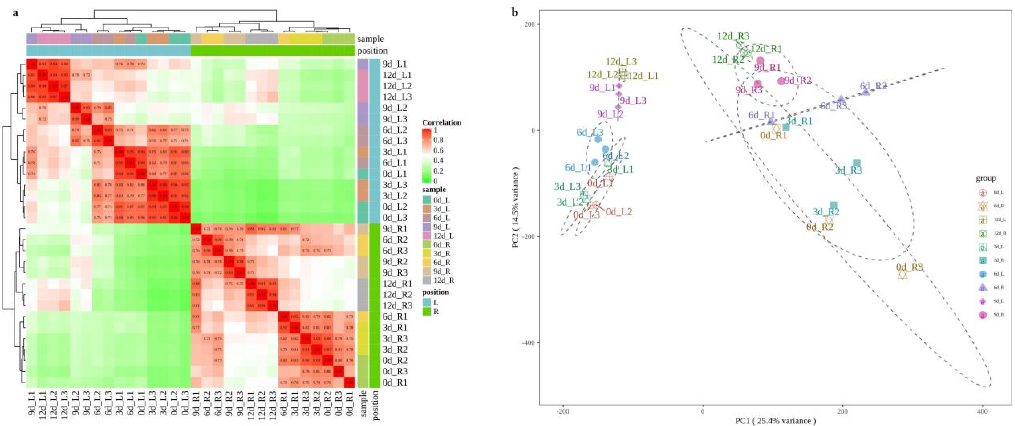
Figure 2. Correlation between samples and PCA analysis. ( a ) Correlation heatmap between samples (the correlation value is greater than 0.7; the correlation method selects person correlation); ( b ) principal component analysis (ellipse shows 95% confidence interval).